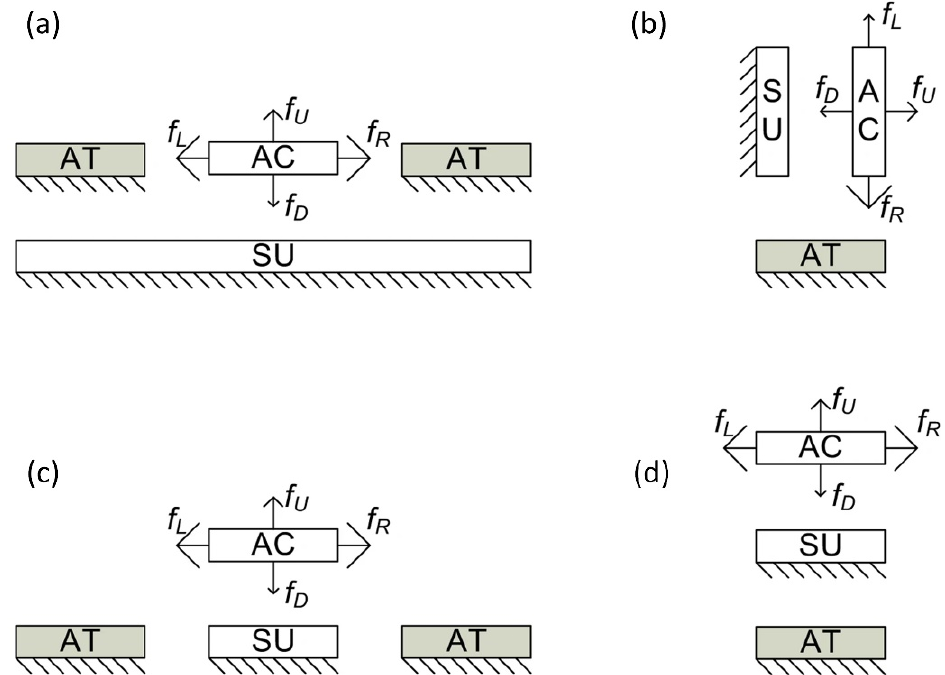
Figure 2. Various repulsive actuators. The AT is the attracting electrode, the SU is the suppressing electrode, and AC is the actuated electrode. ( a ) Levitation of comb-drive actuators. ( b ) In-plane repulsive actuator. The movement direction of AC is to left or right. ( c ) Out-of-plane repulsive actuator. ( d ) Three-layered repulsive actuator. 𝑓 (cid:3013) ; 𝑓 (cid:3022) ; 𝑓 (cid:3019) ; 𝑓 (cid:3005) — attractive forces. Adapted from [34].